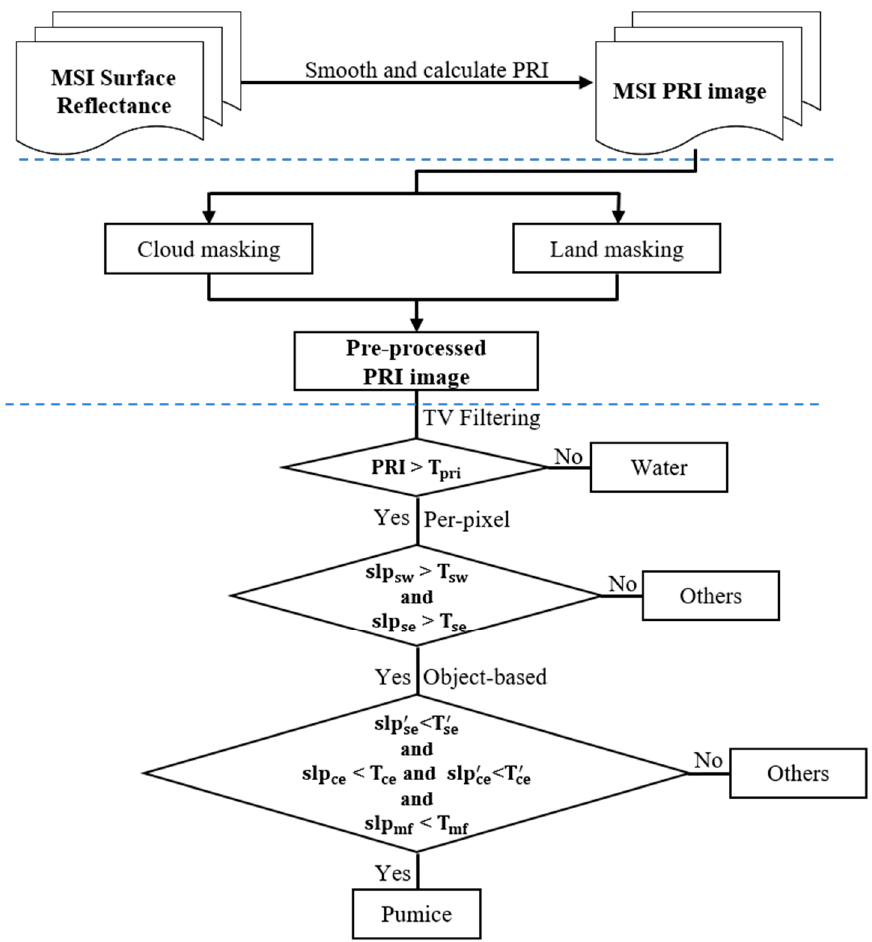
Figure 6. Workflow for automatically extracting pumice pixels in an MSI